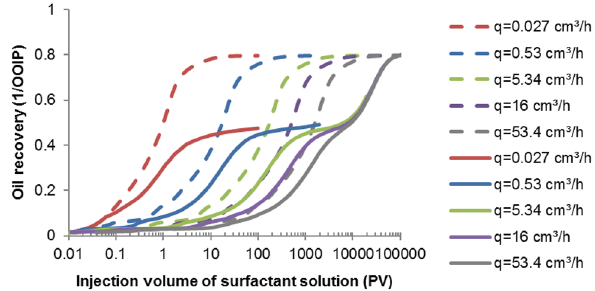
Fig. 13 Comparison of oil recovery versus injection volume of sur- factant solution curves of the base case (with surfactant diffusion) and the contrastive case (without surfactant diffusion). Dashed curves are oil recovery with surfactant diffusion; solid curves are oil recovery without surfactant